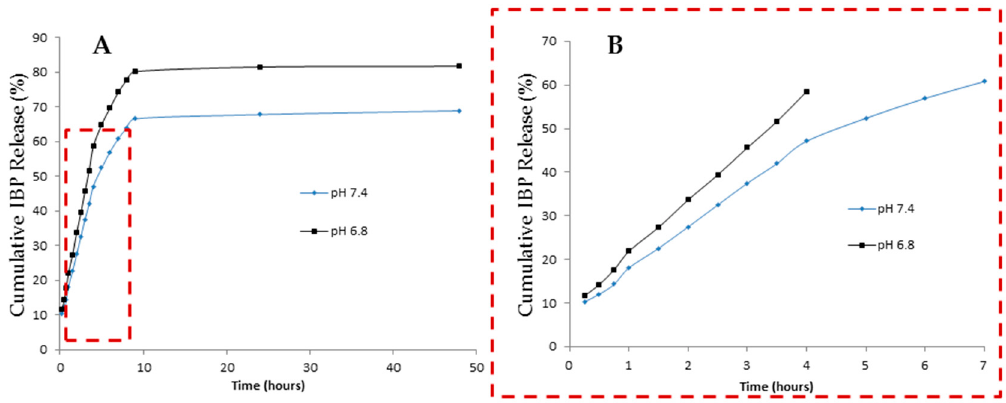
Figure 8. ( A ) In vitro cumulative liberation studies at various pHs; ( B ) Korsmeyer-Peppas adjustment for 60% of the release at different pHs.